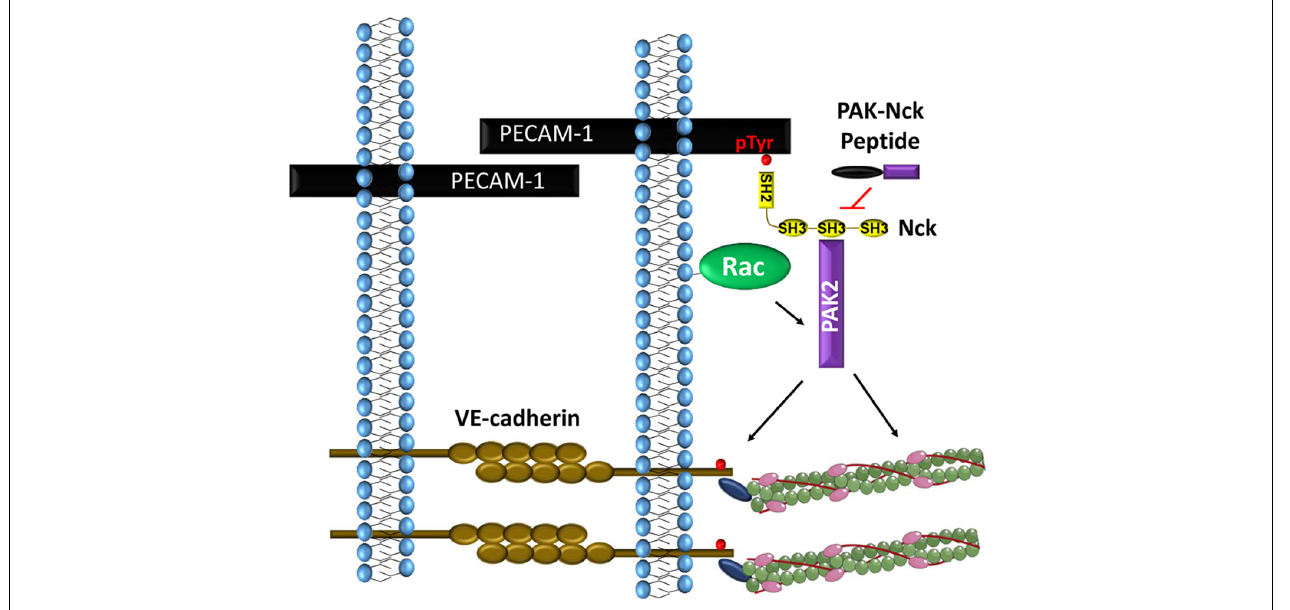
FIGURE 4 | PECAM-1 phosphorylation recruits Nck1 and Nck2 to endothelial cell-cell junctions. Nck1-dependent PAK activation promotes VE-cadherin phosphorylation and local myosin-dependent contractility to induce paracellular pore